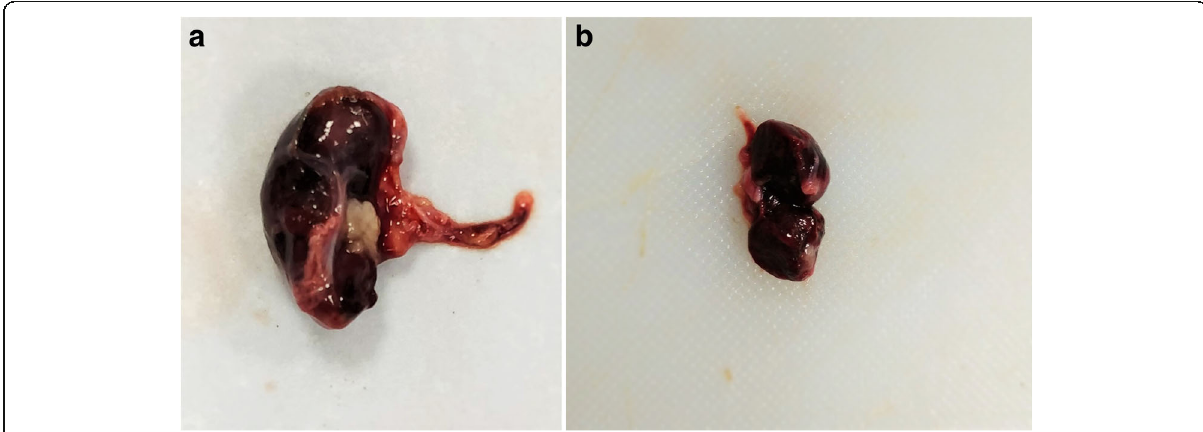
Fig. 4 a , b Gross view and cut section of pituitary show